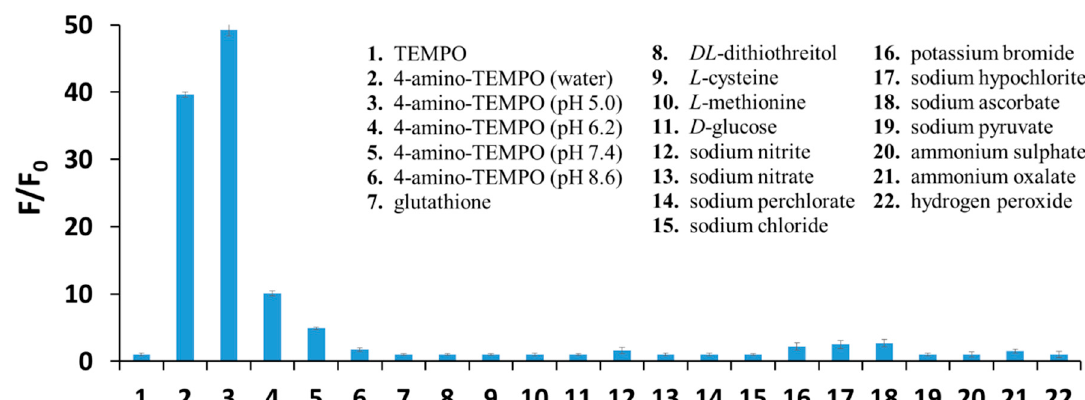
Figure 4. The fluorescence enhancement of 6,7-dihydroxycoumarin (10 µM) in the presence of TEMPO (negative control), 4-amino-TEMPO in different pH and various redox agents, and other species present under biological conditions (100 µM). Each experiment was carried out three times, while fluorescence intensity values were the average of 15 measurements.